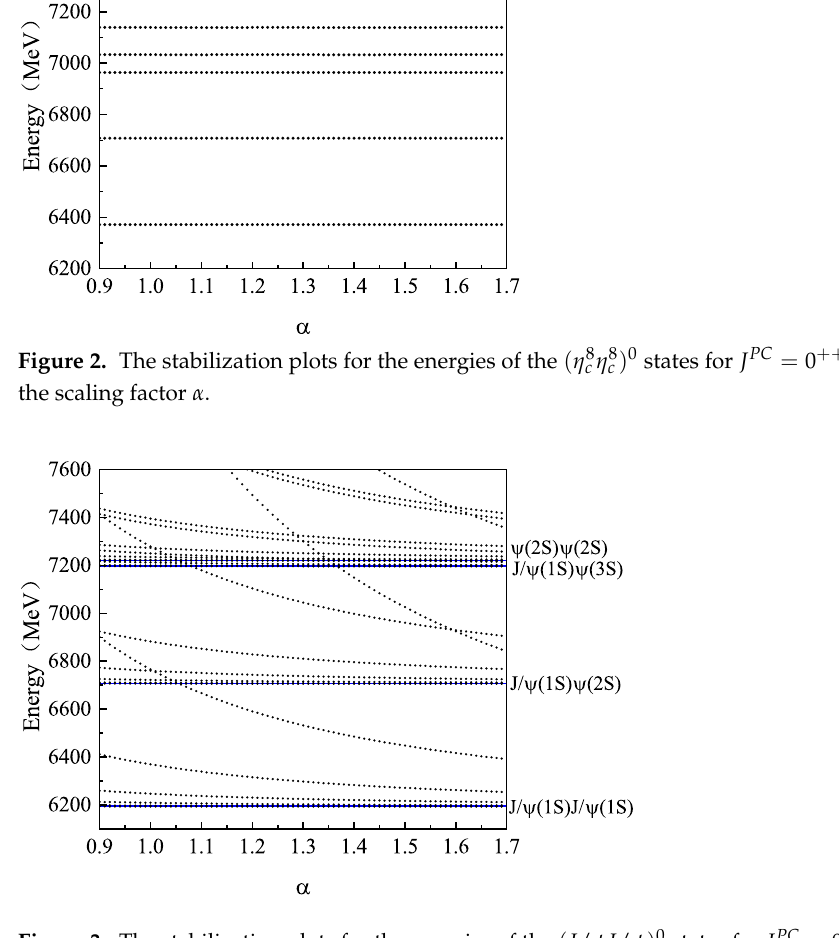
Figure 3. The stabilization plots for the energies of the ( J / ψ J / ψ ) 0 states for J PC = 0 ++ with respect to the scaling factor α